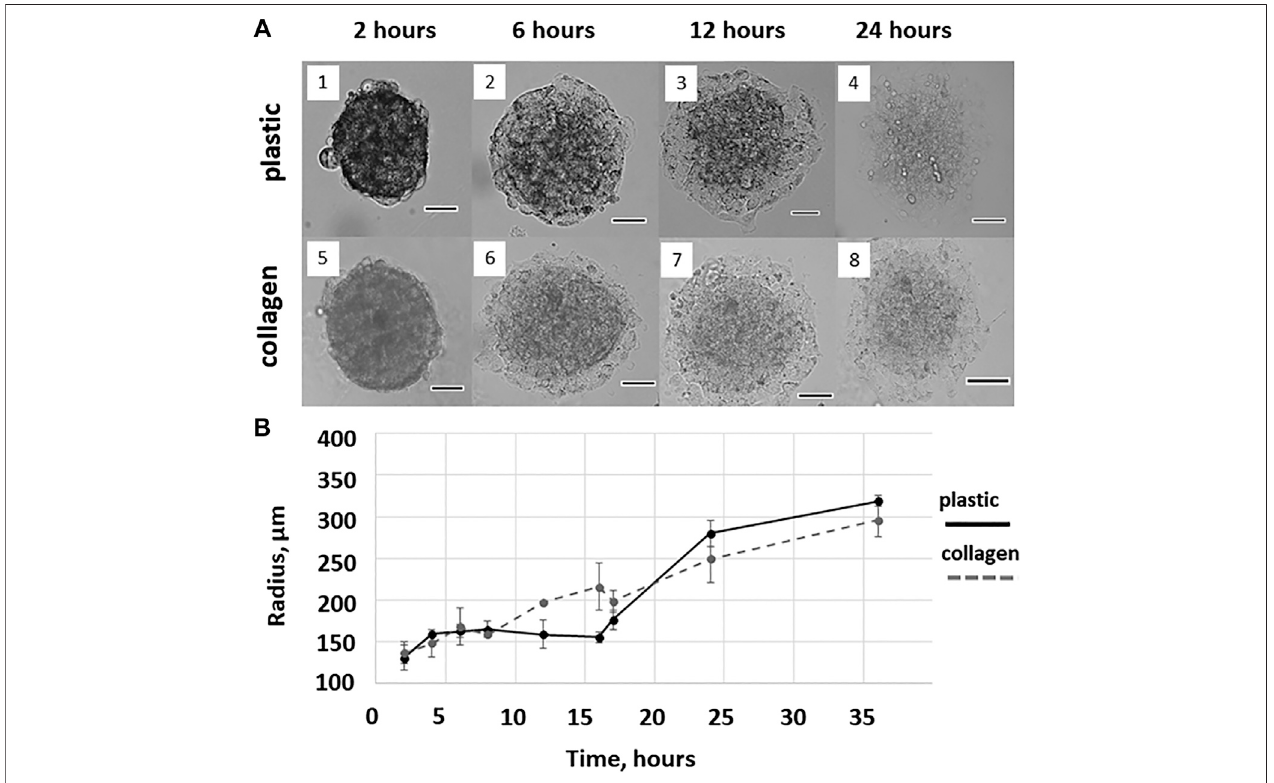
FIGURE 1 | Cell migration from the MCTS on plastic and collagen gel. (A) Representative images of MCTS cultured on plastic or collagen for 2, 6, 12, and 24 h (1,2,3,4and5,6,7,8,respectively).Scaleis100 μ M (B) ThemeanradiuscoveredbythecellsmigratingfromsingleMCTSonplasticorcollagengel.Thecurvesrepresent combined data from two independent experiments and three to nine technical replicates per time point. The data are presented as the mean ±